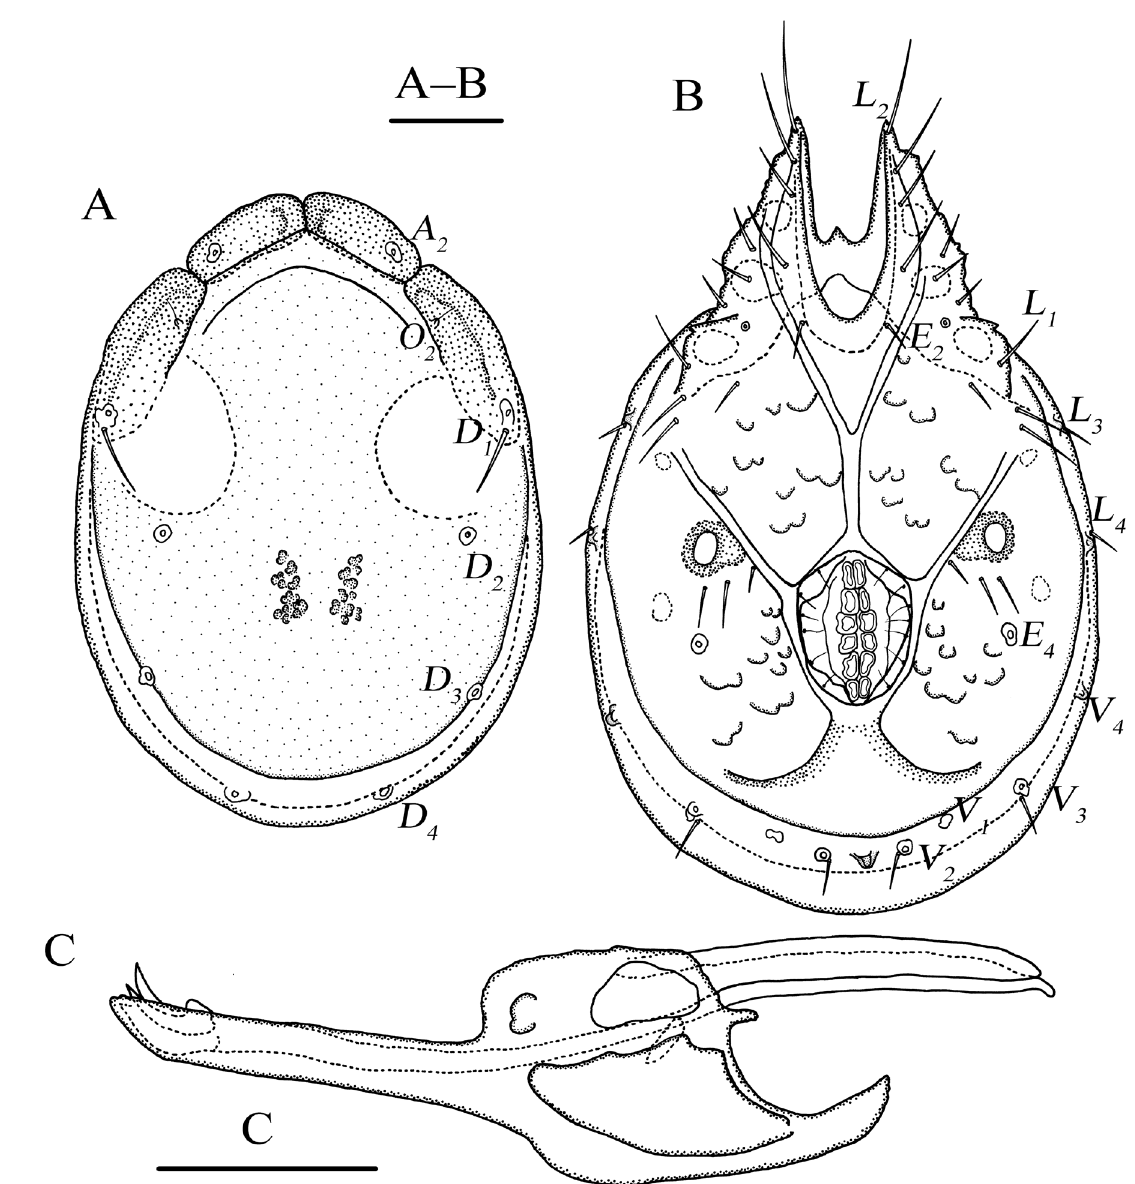
Fig. 1. Torrenticola suptilisrostrum Gu & Guo sp. nov., ♂ , holotype (FJ-TO-20180801). A . Dorsal view. B . Ventral view. C . Infracapitulum and chelicera. Scale bars = 100